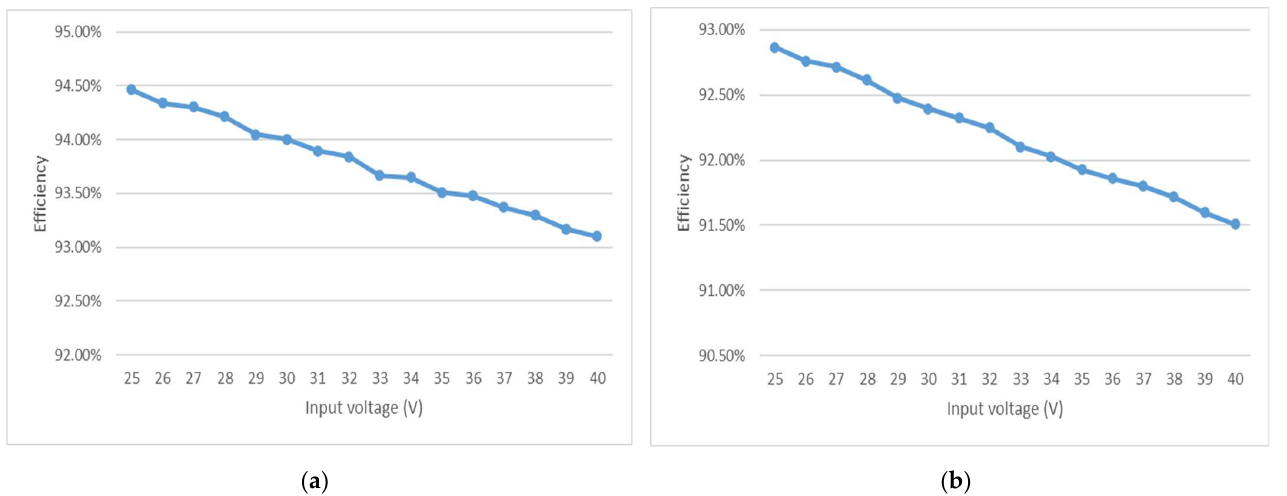
Figure 15. The efficiencies of the converter in different input voltages for different loads: ( a ) The efficiencies for 130 W; ( b ) The efficiencies for 75 W.